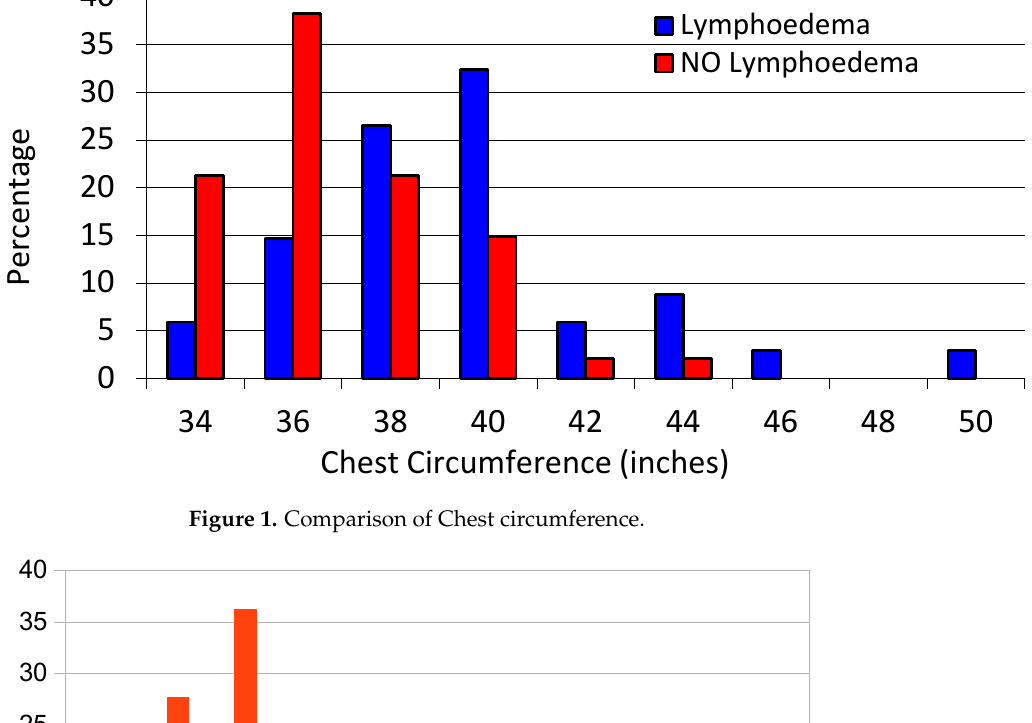
Figure 1. Comparison of Chest circumference.